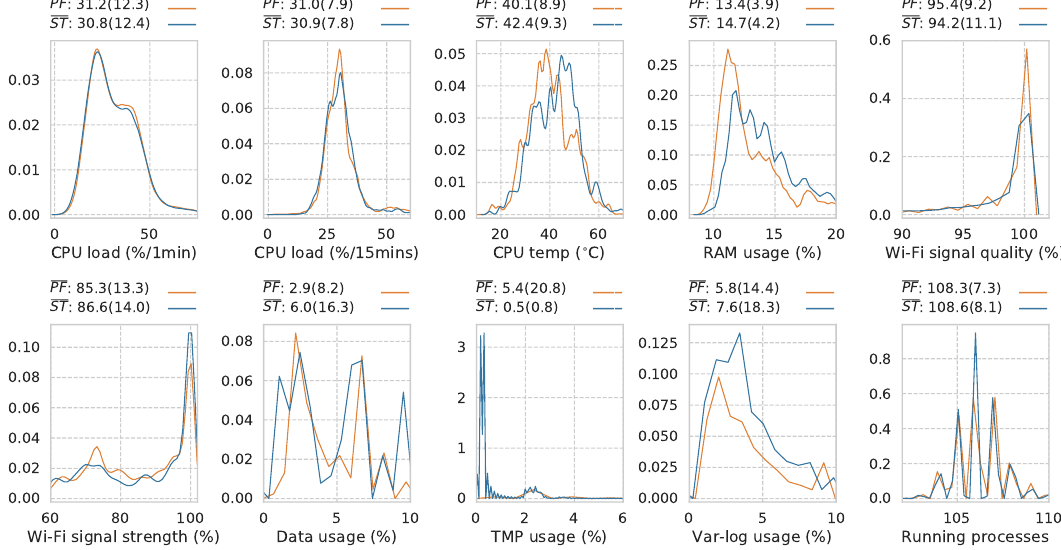
Figure 12. Normalized prefail/stable distributions across telemetry variables including mean and standard deviation in brackets ( PF = prefail mean & ST = stable mean). z-test ρ all <0.001 (prefail n = 241,803 and stable n =